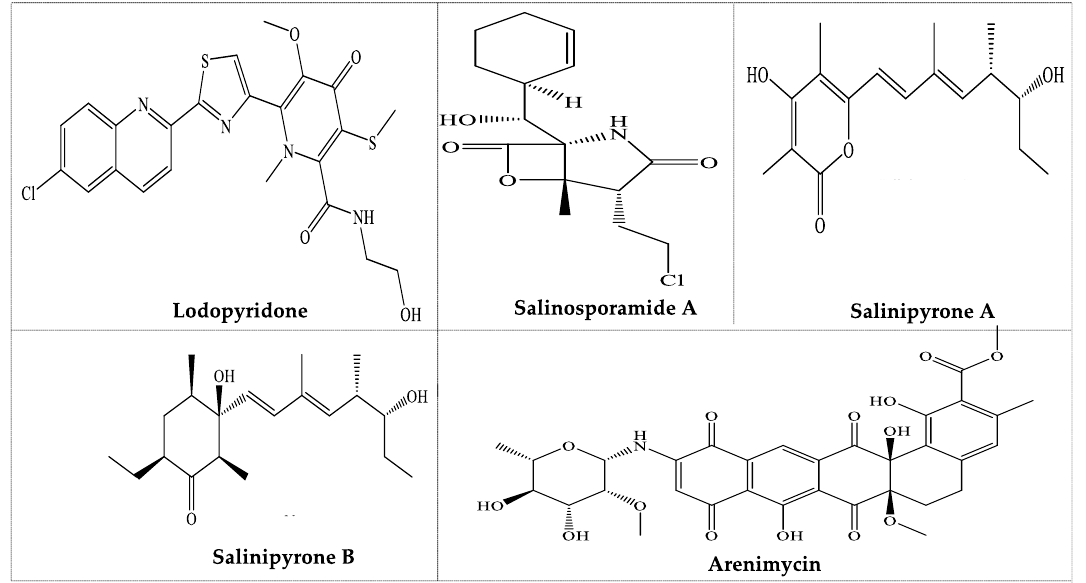
Figure 4. Some novel natural compounds produced by marine actinomycetes.